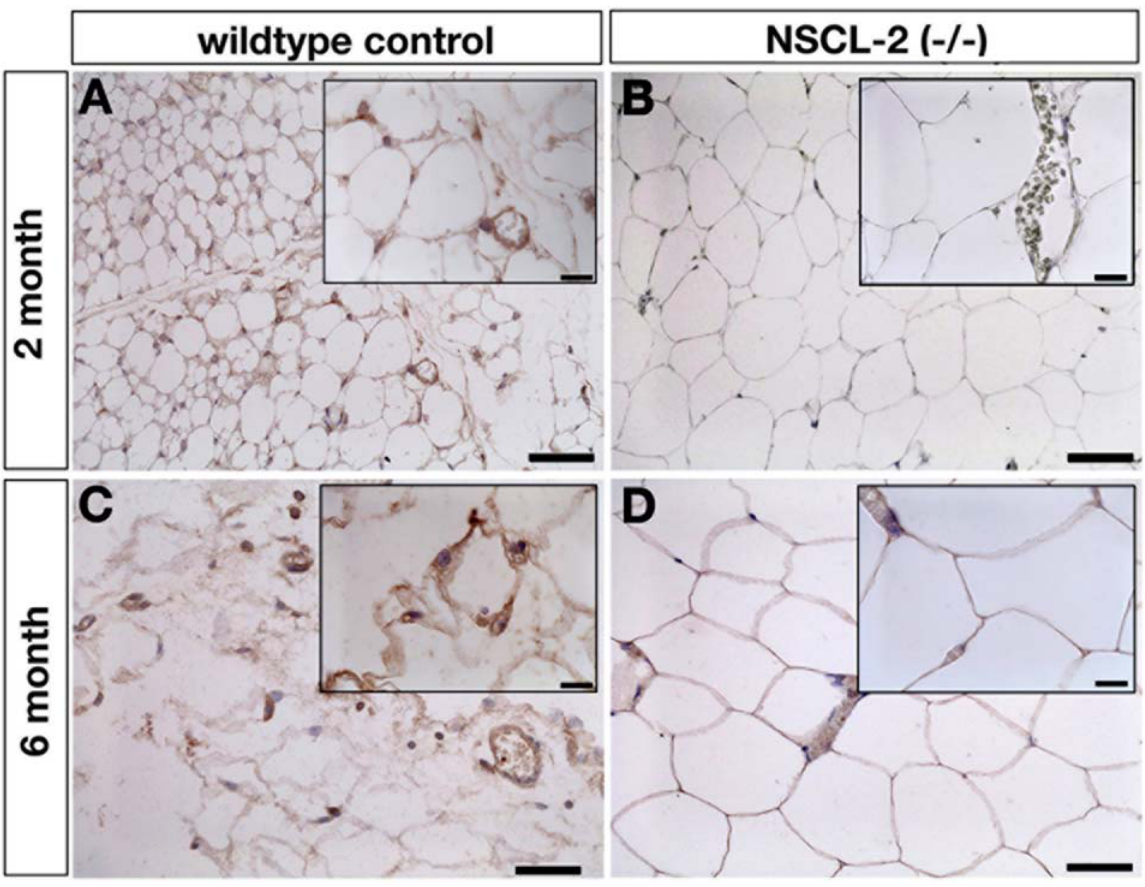
Figure 2. Reduced innervation of WAT in Nscl-2 deficient mice at different postnatal stages. Paraffin sections of WAT from wild-type (A, C) and Nscl-2 2 / 2 mice (B, D) at 2 (A, B) and 6 month (C, D) of age stained with an antibody against peripherin. Sections were taken from epididymal fat tissues. Note the reduction of peripherin positive nerves in Nscl-2 mutants. Scale bars 100 m m; in small pictures 15 m m.